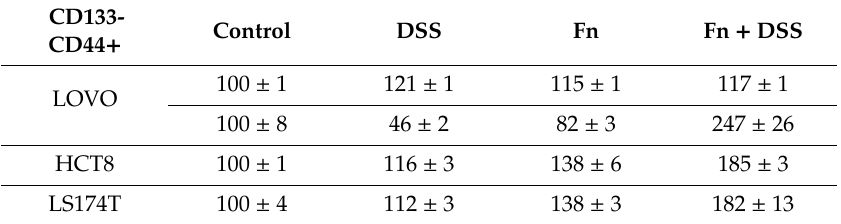
Table 1. Expression profiles of CD133 and CD44 in CRC cell lines using flow